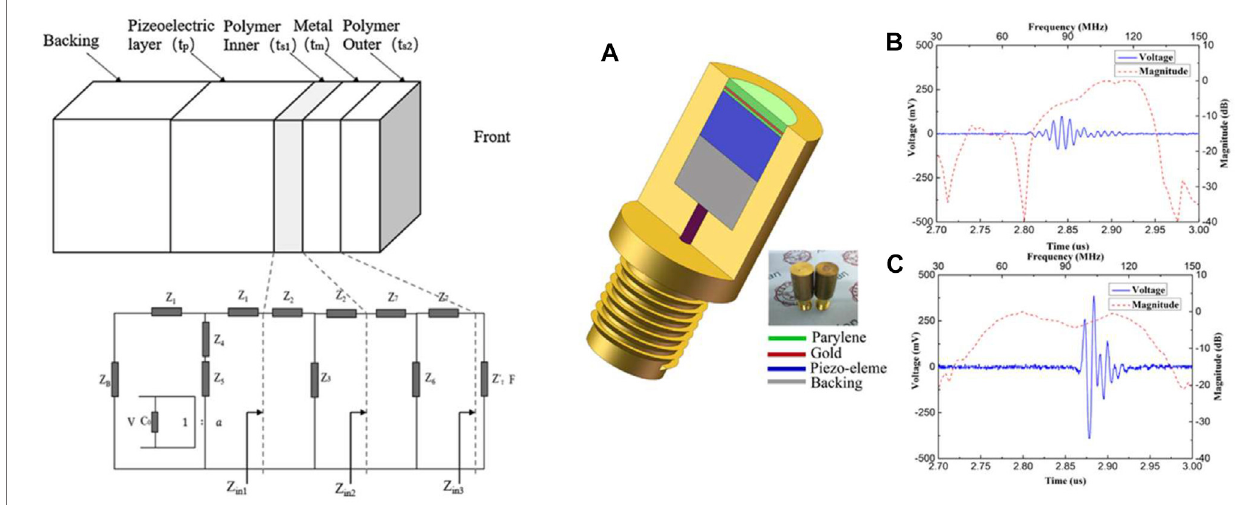
FIGURE 12 | Schematic diagram of the metal polymer matching layer based on transmission line matching network and its practical application in the